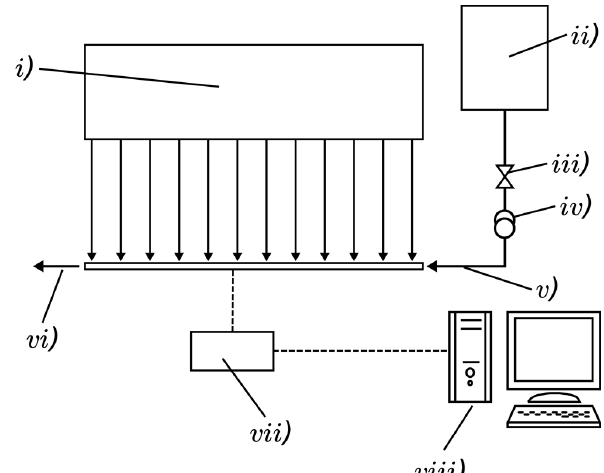
Fig. 2. Operating diagram of the system.